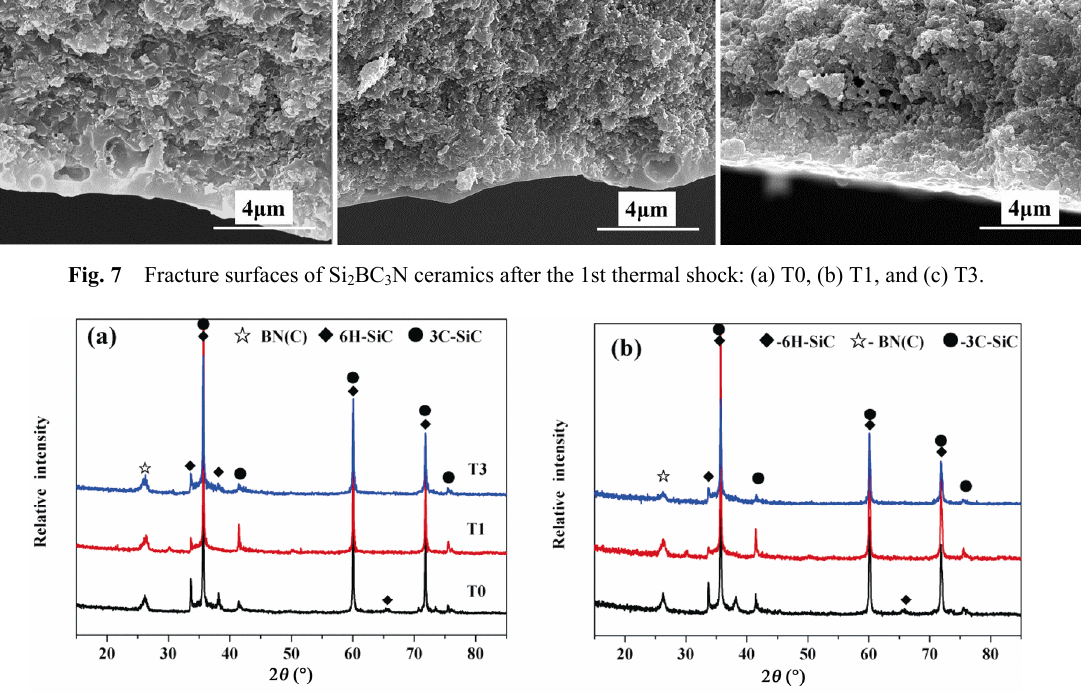
Fig. 8 XRD patterns of Si 2 BC 3 N ceramics surfaces: (a) before and (b) after the 1st thermal shock.